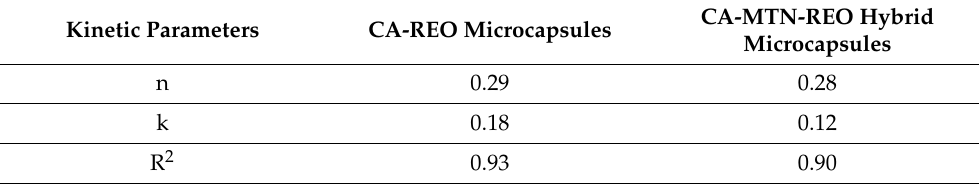
Table 5. Release kinetic parameters (n and k) for the CA and hybrid CA-MTN microcapsules; n is the release exponent related to the drug release mechanisms, k is the rate constant and R 2 is the coefficient of